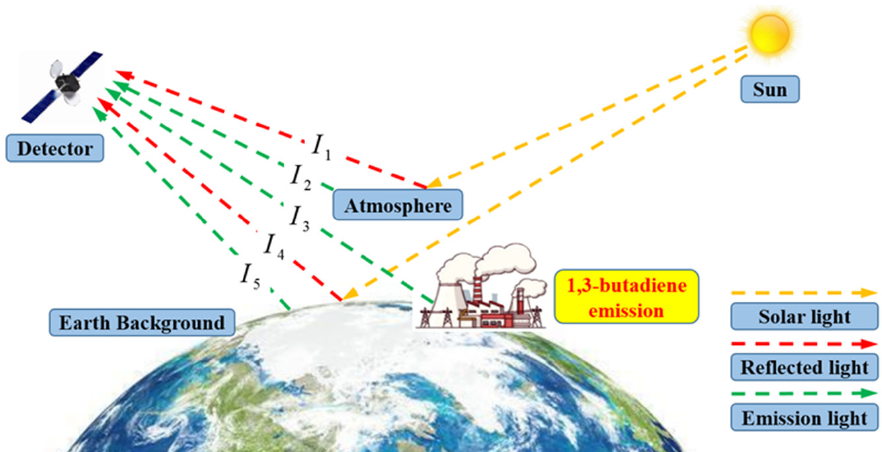
Figure 1. Schematic diagram of 1,3-butadiene space-based detection.